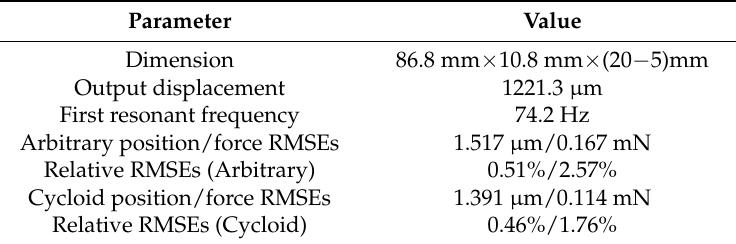
Table 1. Performances of the MFC microgripper.